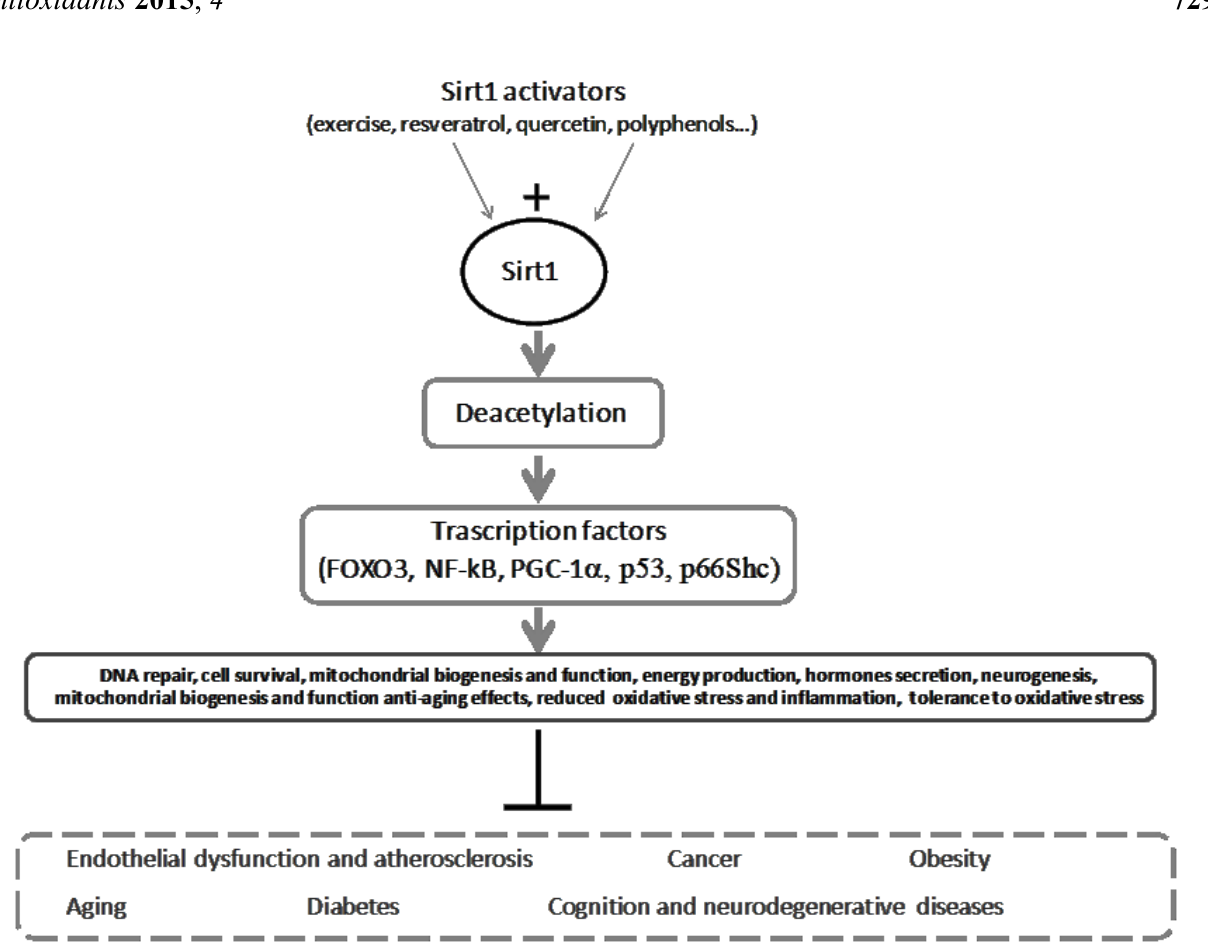
Figure 3. Schematic actions for SIRT1. SIRT1 modulates several different cellular functions by deacetylating transcription factors, thus reducing the onset and progression of chronic degenerative diseases and aging